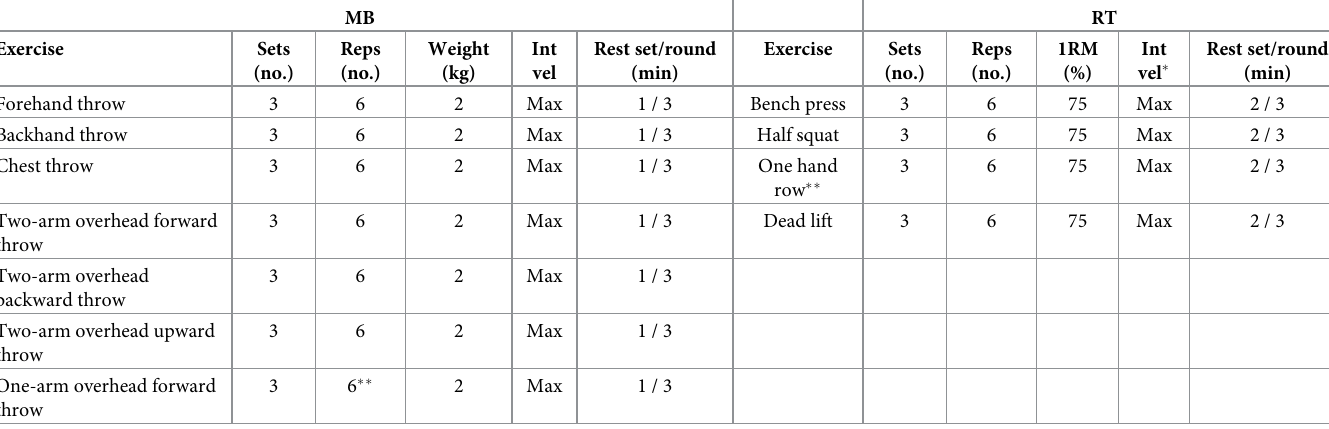
Table 2. Medicine ball throws (MB) and resistance training (RT) exercises. MB RT Exercise Sets